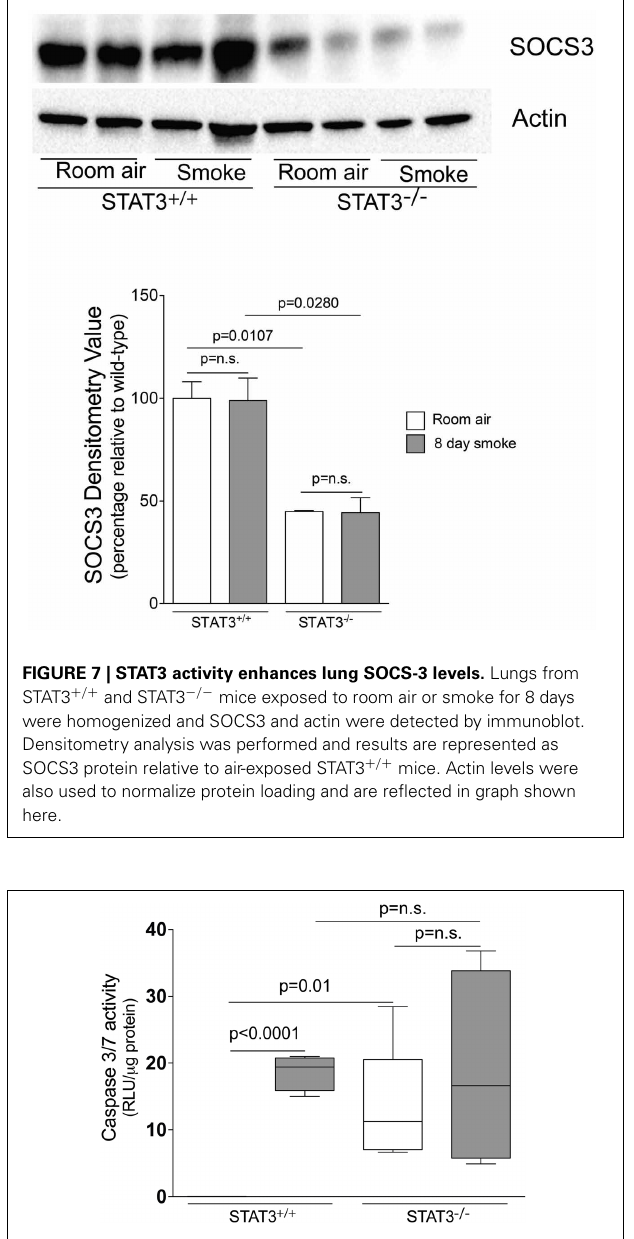
FIGURE 8 | Loss of STAT3 expression increases lung Caspase 3/7 activity. Caspase 3/7 activity was measured from the lung tissue homogenates of control and 8-day smoke exposed STAT3 + / + and STAT3 − / − mice using a specific luminescence assay (Promega). Data are reported as relative luminescence units (RLU). Plots show range and average ± S.E.M. N = 10 in each group. p values shown, comparing both treatments connected by a line. n.s. denotes no significant difference between groups.